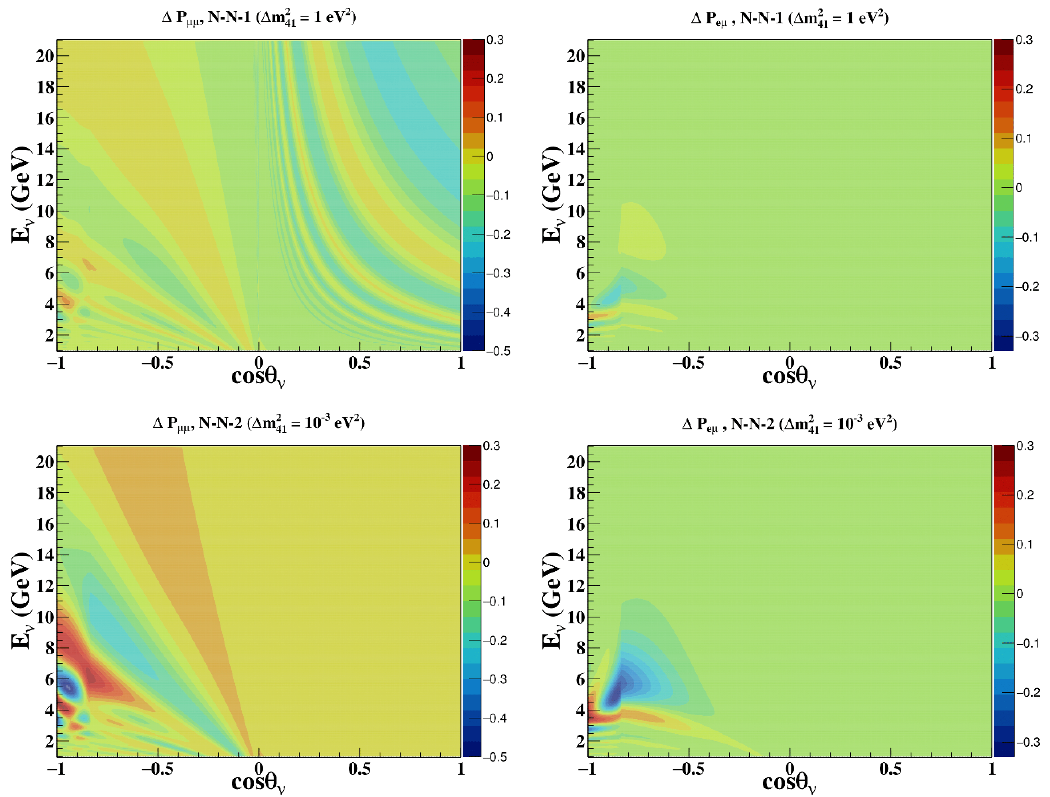
Figure 2 . Oscillograms for (cid:1) P (cid:22)(cid:22) (left panels) and (cid:1) P e(cid:22) (right panels), and for (cid:1) m 2 = 1 eV 2 41 (top panels) and (cid:1) m 2 = 10 (cid:0) 3 eV 2 (bottom panels), after performing the averaging over the fast 41 oscillations. We have used j U e 4 j 2 = 0 : 0025, j U (cid:22) 4 j 2 = 0 : 05, and j U = 0. The hierarchy in the (cid:28) 4 j 2 active sector has been taken to be normal ((cid:1) m 2 > 31